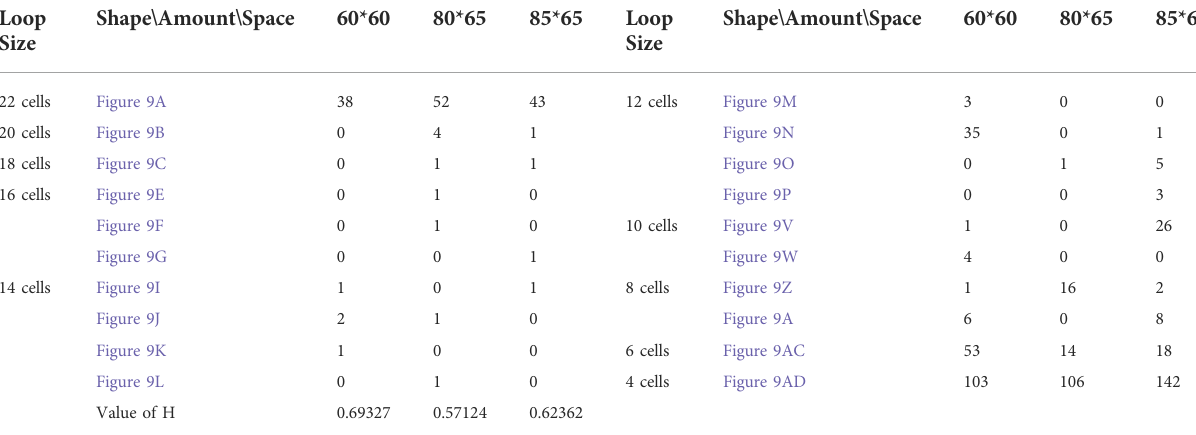
TABLE 6 Statistical numbers of the loops with various structures for the adding mechanism on different cellular spaces starting from the initial con fi guration in Figure 7B. Loop